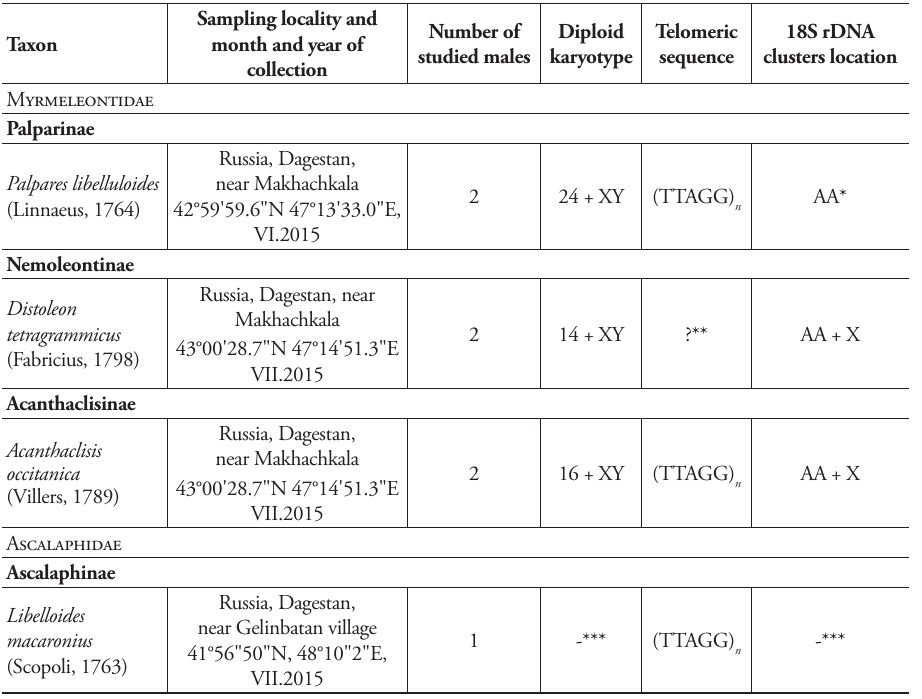
Table 1. Examined material and main karyotypic features obtained during the present study. Taxon